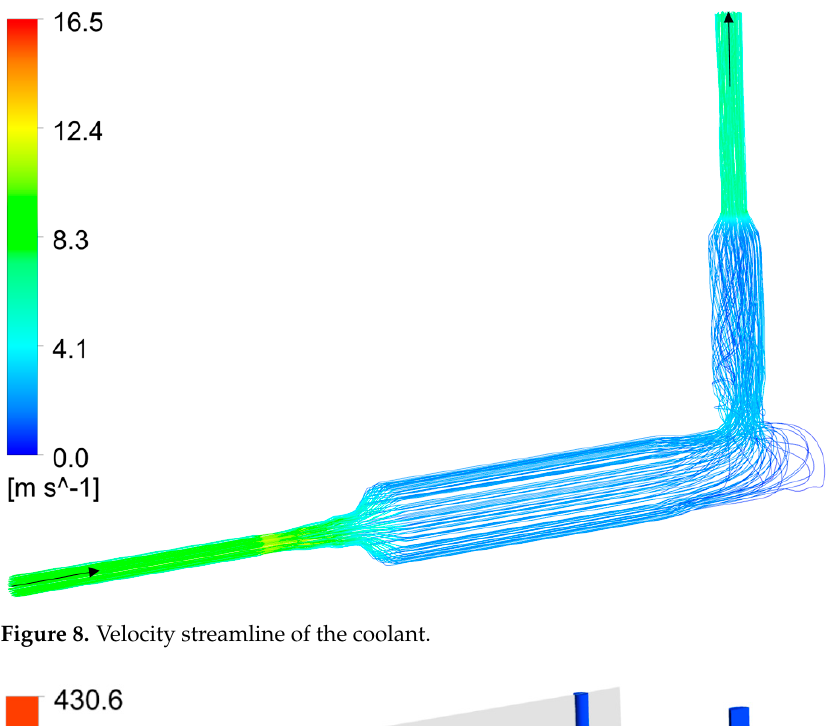
Figure 8. Velocity streamline of the coolant.